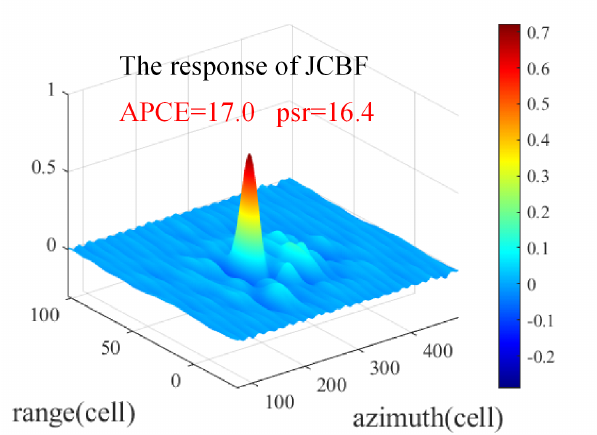
Figure 11. The response map of JCBF (target 2 in frame